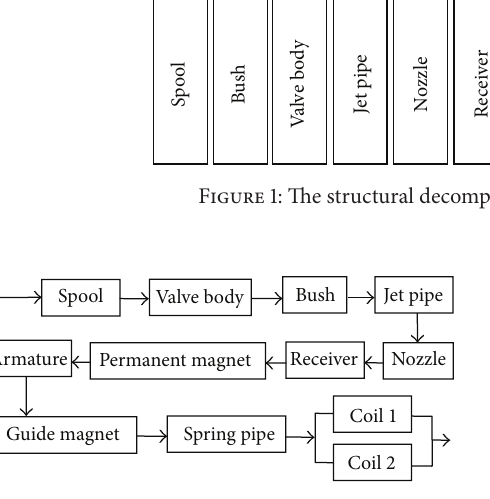
Figure 2: The reliability block diagram of servo